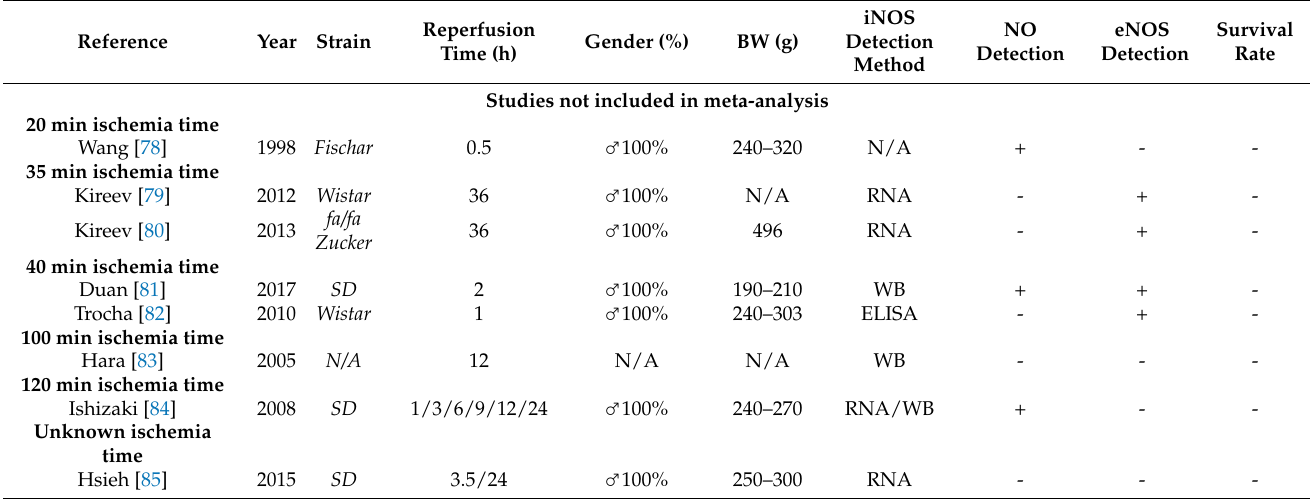
ELISA, Enzyme-linked immunosorbent assay; IHC, immune histochemistry; N/A, not available; RNA, ribonuclein acid; SP, spectrophotometric analysis; SD, Spraque– Dawley ; WB, Western blot; + reported; - not reported.